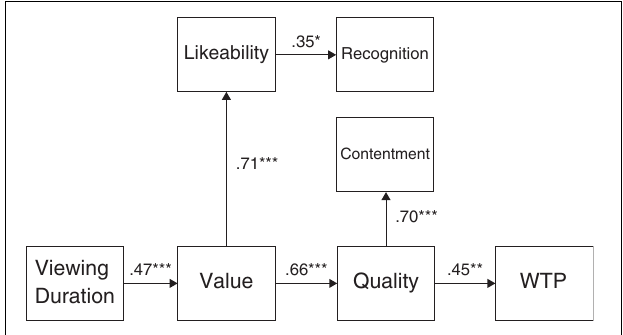
FIGURE 3 | Result of a path analysis. The path coefficients represent standardized partial regression coefficient. ∗ p < 0 . 05; ∗∗ p < 0 . 01; ∗∗∗ p < 0 .